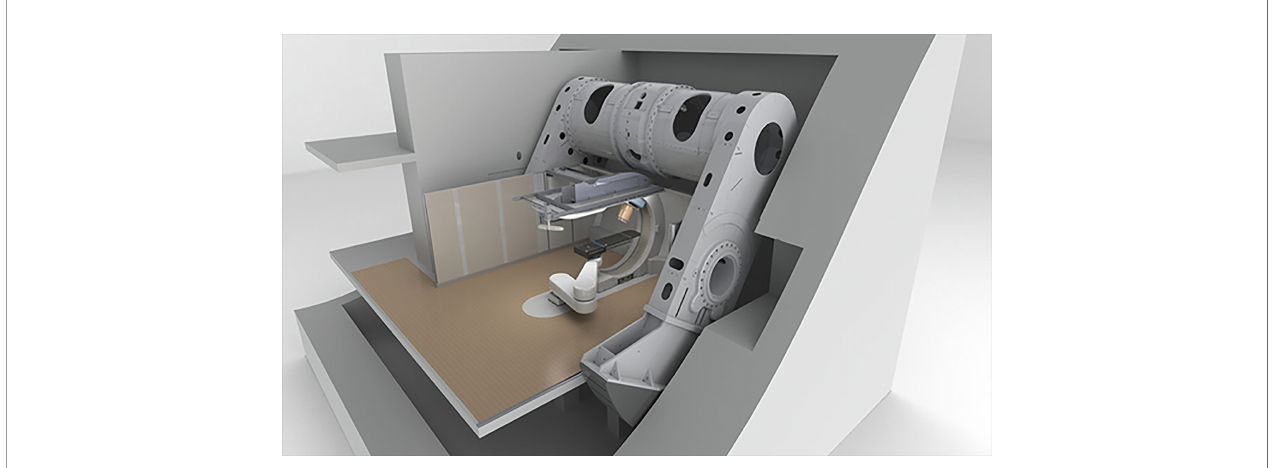
FIGURE 5 | The MEVION S250 gantry-mounted proton synchrocyclotron – after Jongen